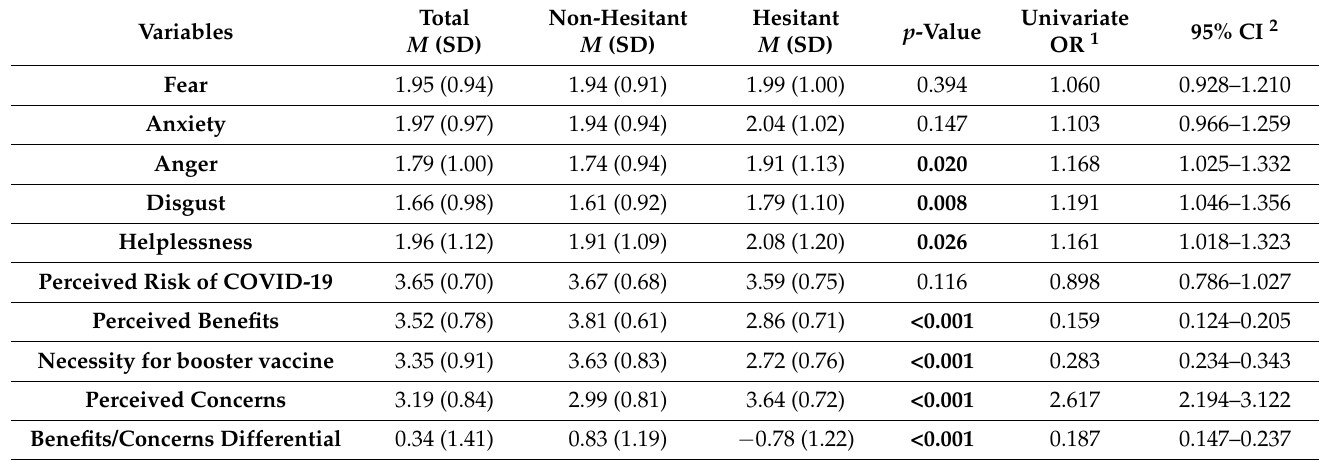
Table 2. Mean scores and standard deviation of all emotional and psychological variables, with univariate analyses